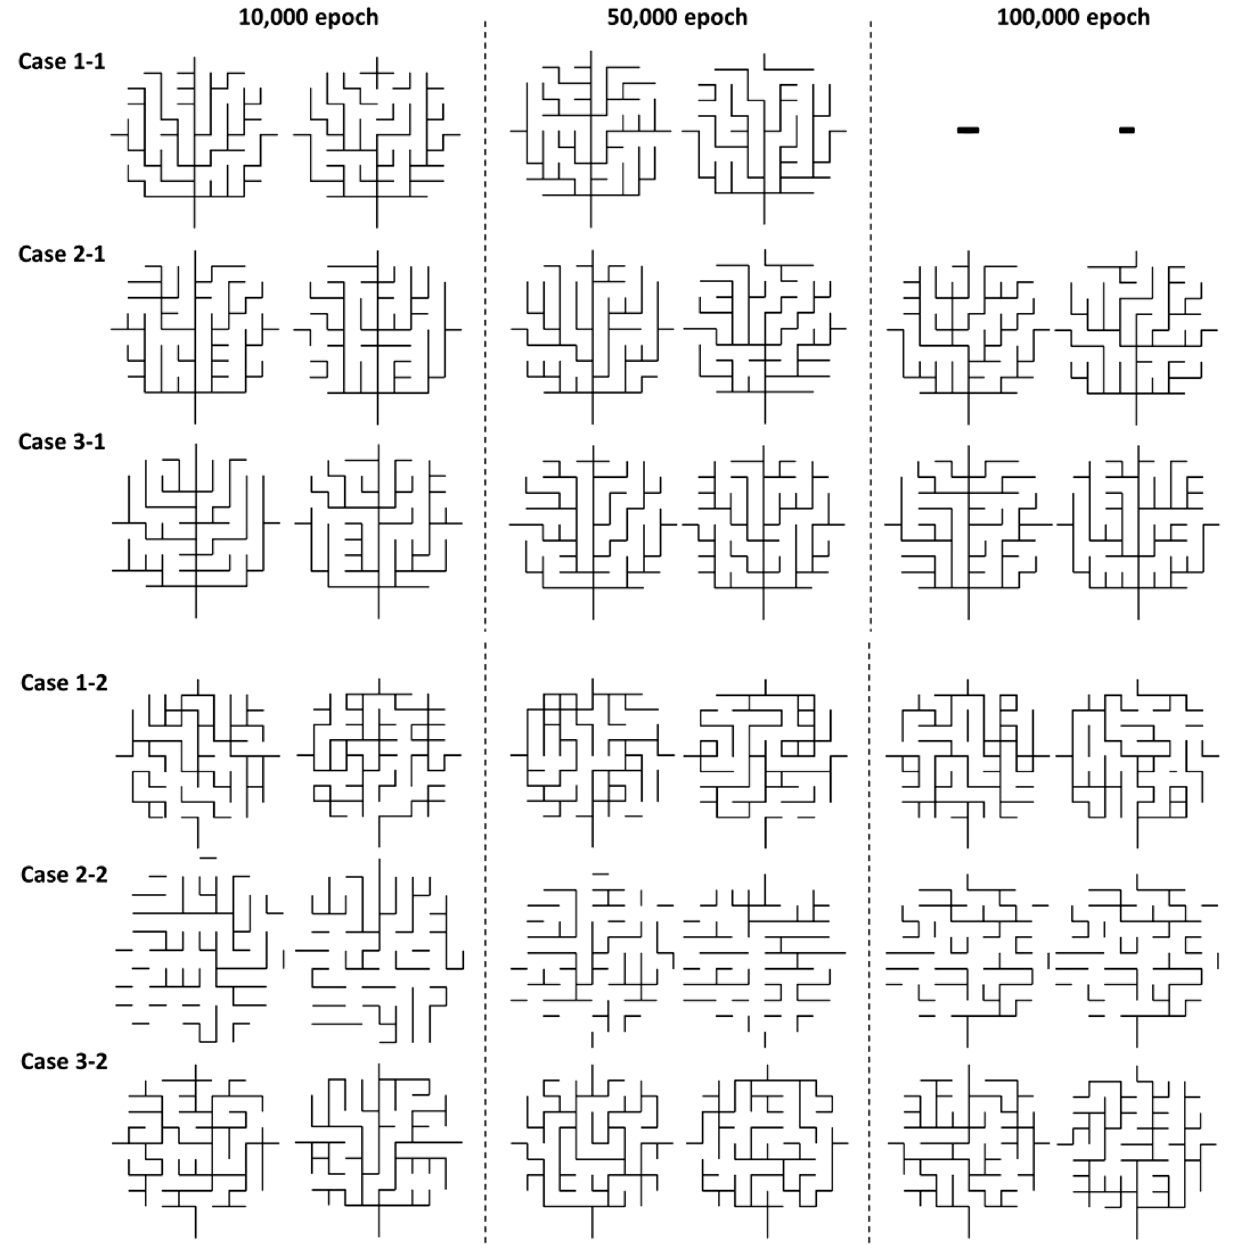
Figure 7. Comparison of generated drainage networks for six cases at 10,000, 50,000 and 100,000 epochs. Note that Subcase 1 (Case 1-1, 2-1, 3-1) is with the less complex network and Subcase 2 (Case 1-2, 2-2, 3-2) with the more complex network. Cases 1-2 and 2-2 rarely generated the fully connected drainage networks although the training results (Fig. 6) showed that both D and G models were trained and the accuracy of the D model increases as epochs